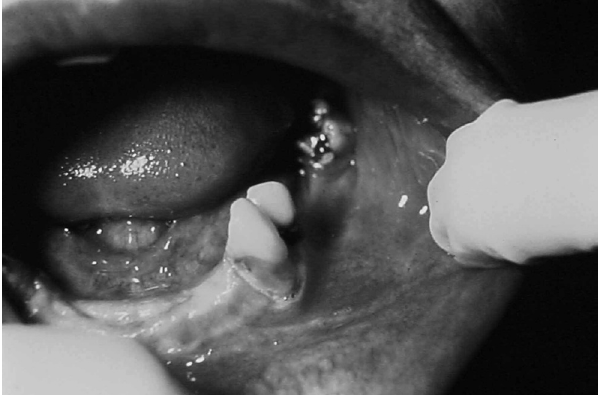
Figure 2 - Discrete loss of definition on the left inferior vestibular fornix. The oral expansion of the mandibular bone was due to slowly increase in the size of the central lesion